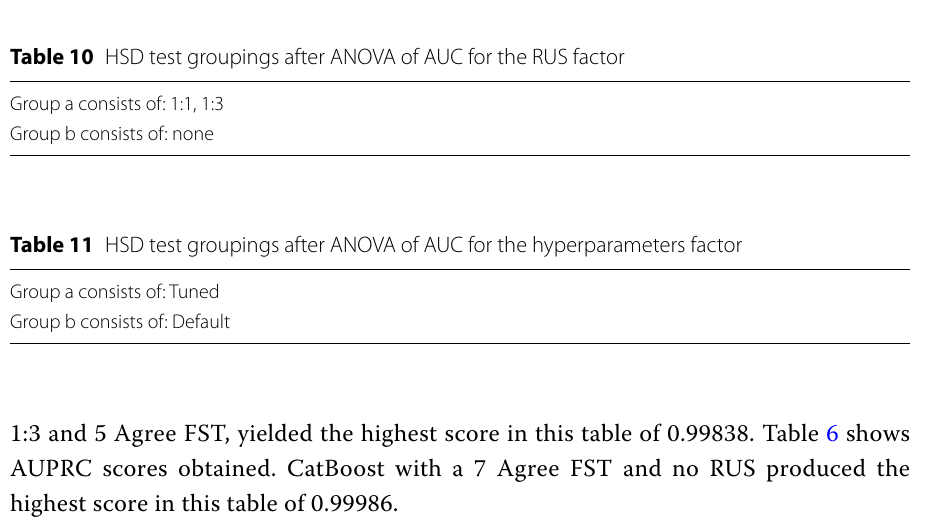
AUPRC scores obtained. CatBoost with a 7 Agree FST and no RUS produced the highest score in this table of 0.99986.